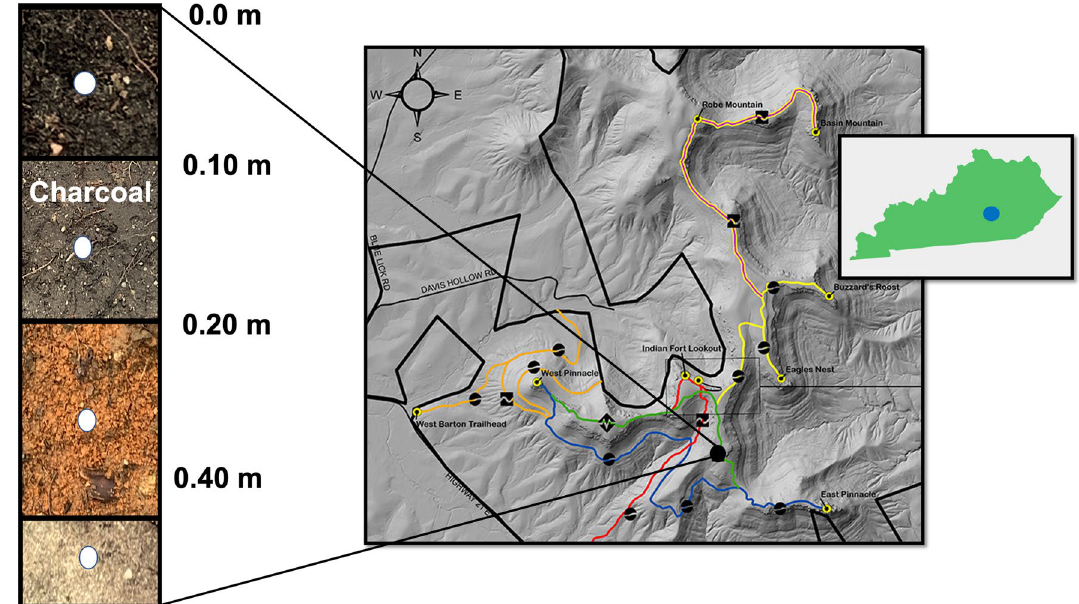
Figure 8. The location, stratigraphy, and sample site (white circles) of the Indian Fort earthworks site, Madison County, Kentucky. Kenneth Barnett Tankersley used Microsoft PowerPoint for Mac Version 16.41 (www. micro soft. com) to create this figure.